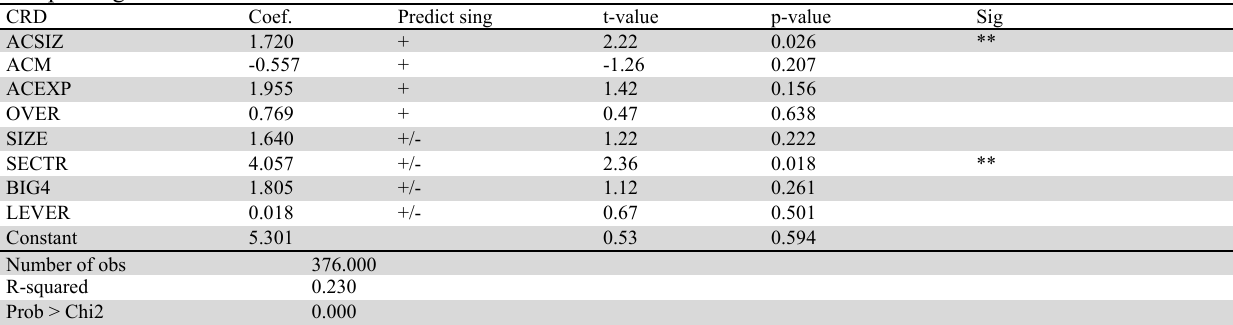
Multiple Regression